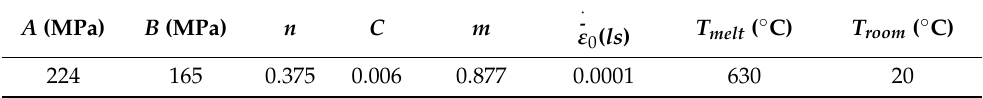
Table 1. Coefficient of the Johnson–Cook constitutive model for the Al matrix material. A (MPa)